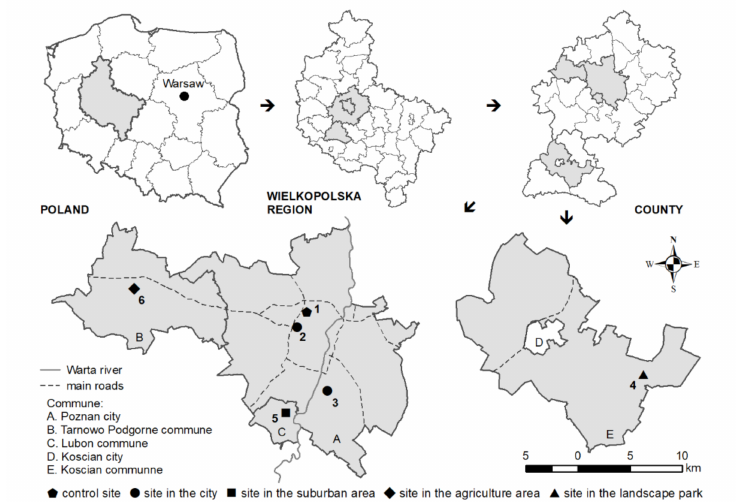
Figure 1. Location of exposure sites. Source: own study based on data from National Geodetic and Cartographic